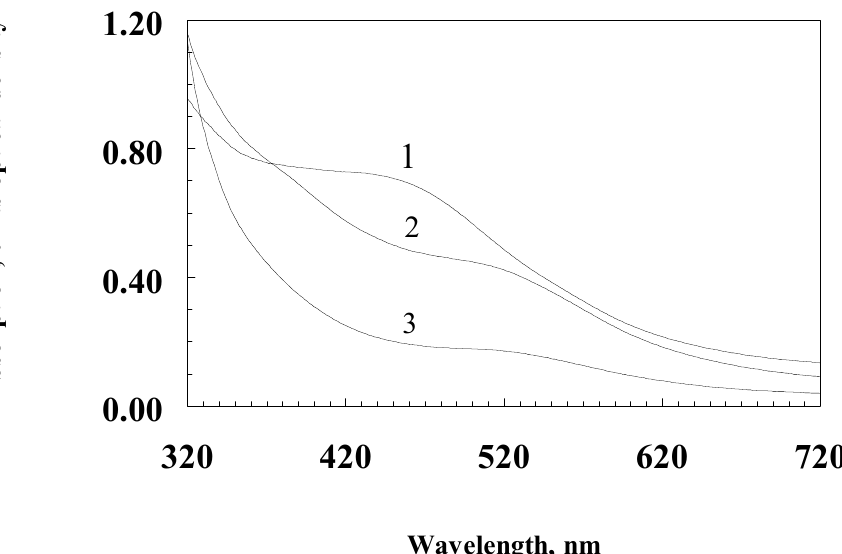
Figure 2. The absorption spectrum of purified Hermetia illucens ommochromes in a mixture of 0.1 M potassium phosphate buffer (pH 7.4) and methanol-HCL in a volume/volume ratio of 2:1. Curve 1—initial spectrum; curves 2 and 3—in the presence of 1.5% hydrogen peroxide solution (curve 2—20 min of reaction; curve 3—2 h of reaction).